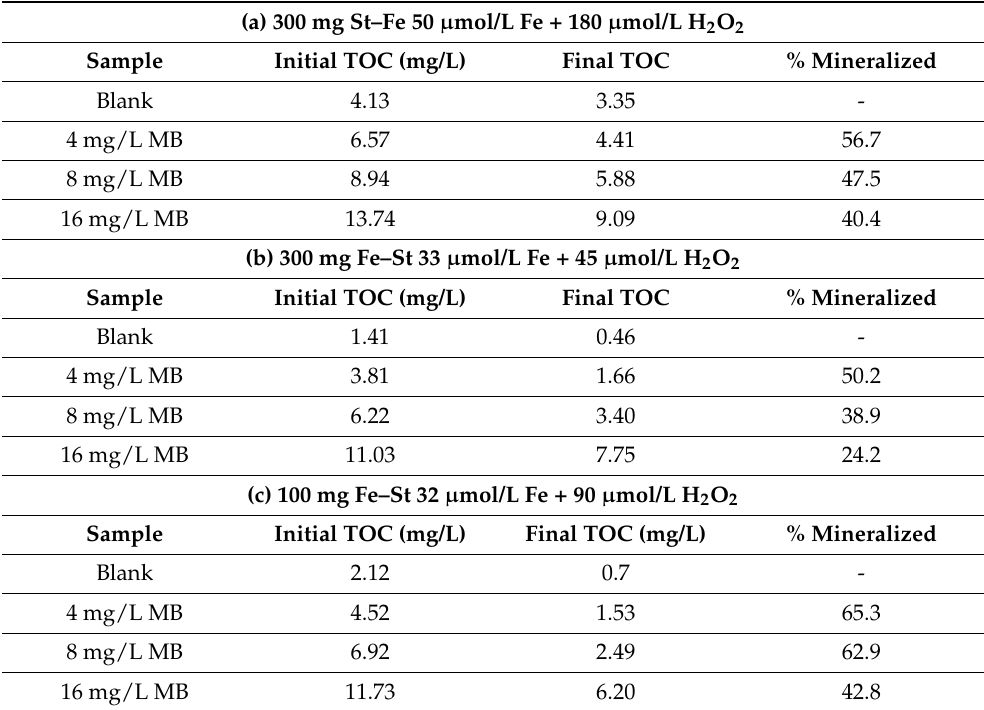
Table 3. TOC results for the degradation of MB at various concentrations with ( a ) 300 mg St–Fe, ( b ) 100 mg Fe–St, and ( c ) 100 mg Fe–St NPs.